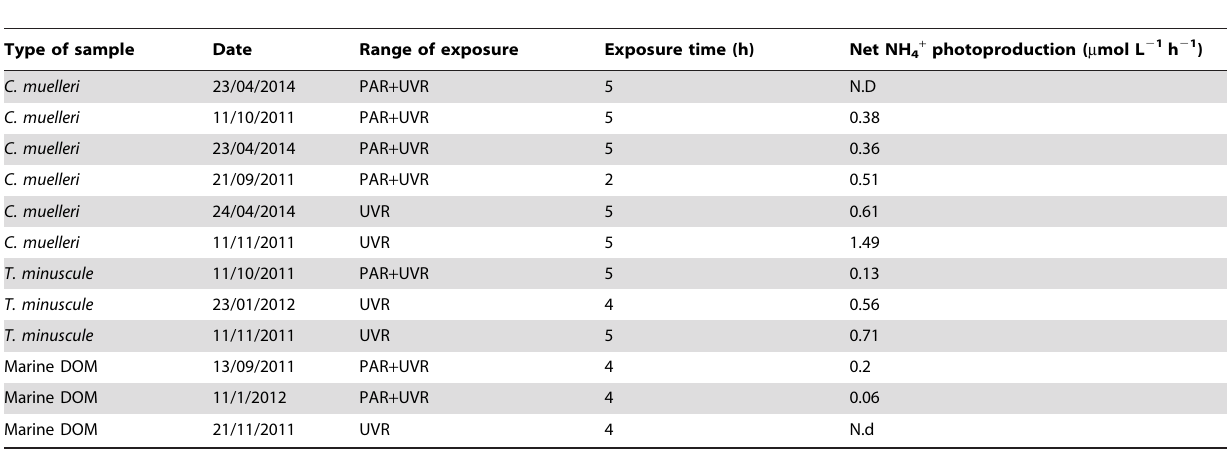
Table 3. Summary of ammonium production rates (expressed in m mol L 2 1 h 2 1 ) obtained for diatom-derived DOM and marine DOM (seawater filtered through 0.7 m m) during this study.